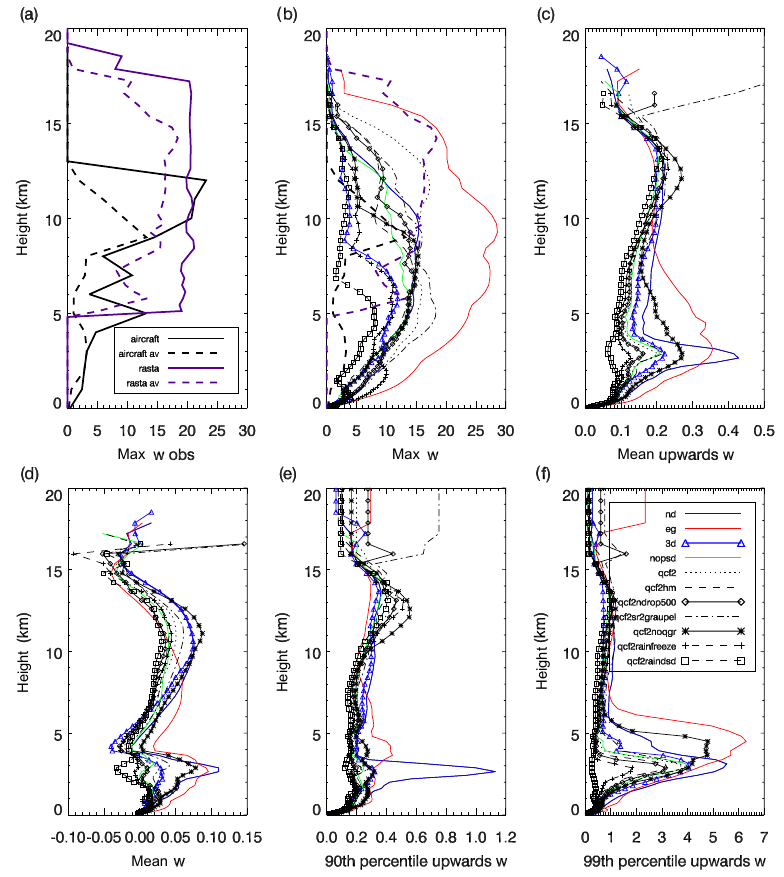
Figure 11. (a) Maximum vertical velocity observed by the aircraft and derived from RASTA (Radar SysTem Airborne) for the times 23:00– 24:00UTC. Solid lines use the highest-resolution observations, dashed lines use the observations averaged to the 1km resolution. Modelled in-cloud vertical velocity statistics (ms − 1 ) over the radar domain for the times 23:00–24:00UTC: (b) maximum, (c) updraught mean, (d) mean, (e) updraught 90th percentile and (f) updraught 99th